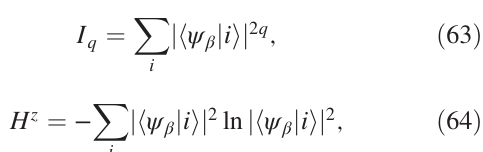
FIG. 10. The inverse participation ratio I 2 ¼ function of the average classical (at a vanishing transverse field) energy level spacing δϵ in units of the typical coupling V different numbers M of states in the impurity band. We see that ≥ 1 the eigenstates become localized and I for δϵ =V typ independent of M , indicative of eigenstates localized on single bit string